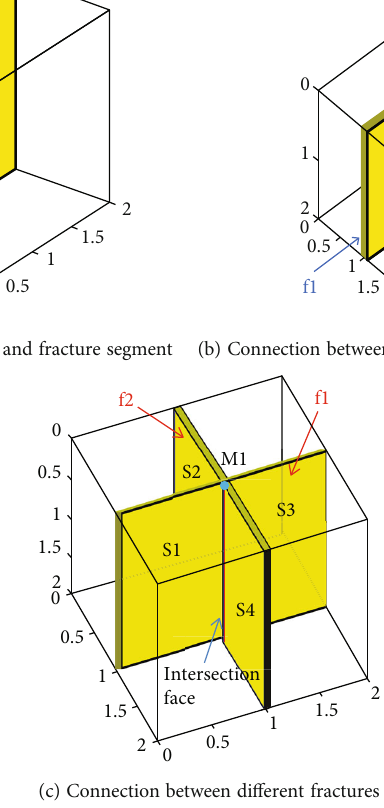
Figure 1: Three kinds of connections between the fracture and